Question: Give a one-sentence summary of this figure.
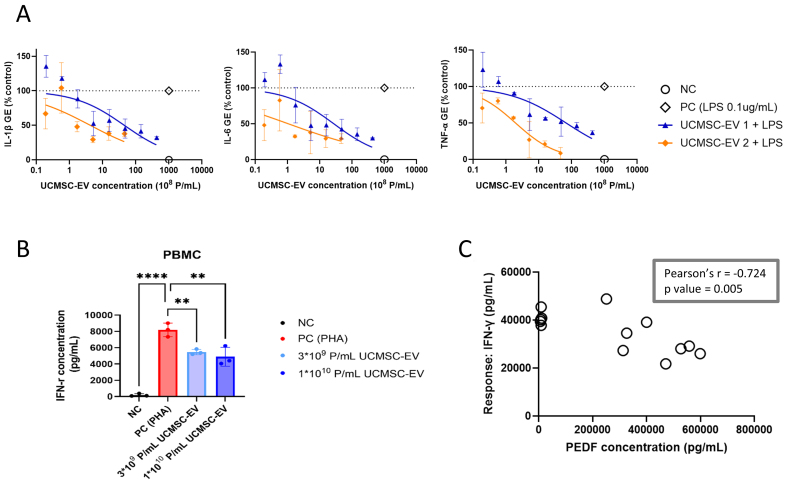
Answer: UCMSC-EVs suppress inflammatory cytokines in both LPS-induced THP-1 and PHA-induced PBMC inflammatory models. (A) The gene expression of inflammatory cytokines (IL-1β, IL-6, TNF-α) was quantified by RT-qPCR. The relative expression of each gene was first quantified from fold change (2 -ΔΔCt ) and then normalized in between LPS control (PC: 100%) and naïve state (NC: 0%). The dose-response curve shows percent cytokine gene expression at different UCMSC-EV concentrations compared to maximum cytokine levels (LPS alone without UCMSC-EVs; 100%). Data are presented as the mean ± SD, based on two independent biological replicates for the sample groups and three independent biological replicates for the control groups; (B) The bar graph shows that PHA markedly increased IFN-γ secretion in PBMCs (46-fold differences between positive and negative controls, **** P < 0.0001, one-way ANOVA with Dunnett’s post hoc test, n = 3 replicates). Treatment with UCMSC-EVs significantly reduced IFN-γ concentrations compared with PC groups (35%-42% reduction with EV treatment, ** P < 0.01, one-way ANOVA with Dunnett’s post hoc test, n = 3 replicates); (C) The dot plot showed the negative correlation between PEDF concentration of UCMSC-EVs quantified by ELISA and the IFN-γ concentrations measured from the UCMSC-EV treatments in the PHA-induced PBMC model. The r = -0.724, P = 0.005, n = 11 UCMSC-EV production lots. IL-1β: Interleukin-1 beta; IL-6: interleukin-6; IFN-γ: interferon gamma; LPS: lipopolysaccharide; NC: negative control; PBMCs: peripheral blood mononuclear cells; PC: positive control; PEDF: pigment epithelium-derived factor; PHA: phytohemagglutinin; RT-qPCR: reverse transcription quantitative polymerase chain reaction; THP-1: human monocytic leukemia cell line THP-1; TNF-α: tumor necrosis factor-alpha; UCMSC-EVs: umbilical cord mesenchymal stem cell-derived extracellular vesicles; SD: standard deviation; ANOVA: analysis of variance; ELISA: enzyme-linked immunosorbent assay.